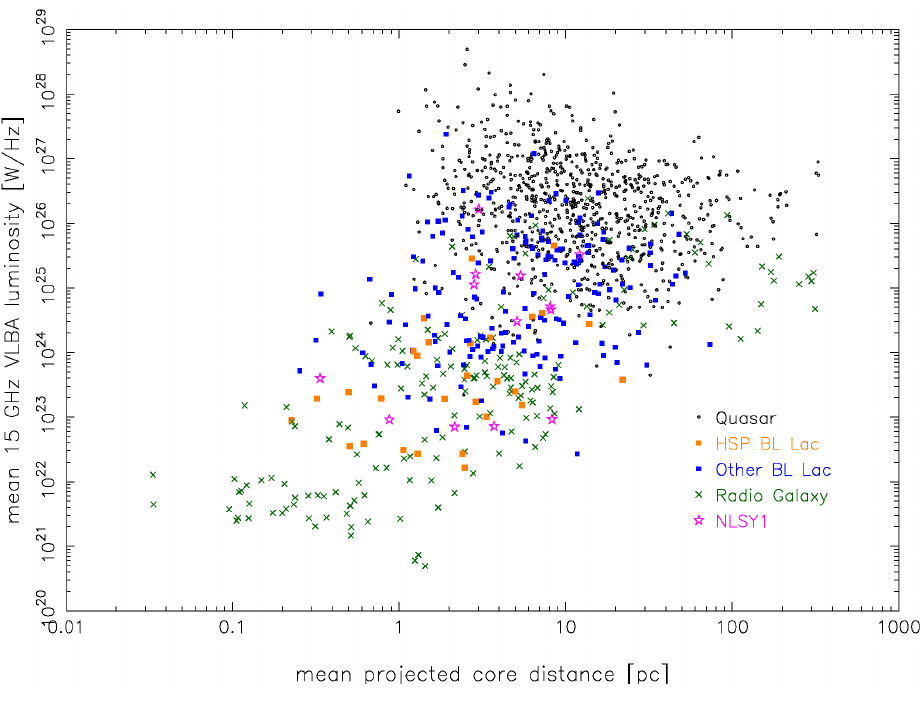
Figure 5. Plot of 15 GHz luminosity versus projected distance downstream from the core feature, for jet features in the MOJAVE survey. Black circles represent quasars, orange squares high spectral peaked BL Lacs, blue squares other BL Lacs, green crosses radio galaxies, and purple stars NLSY1